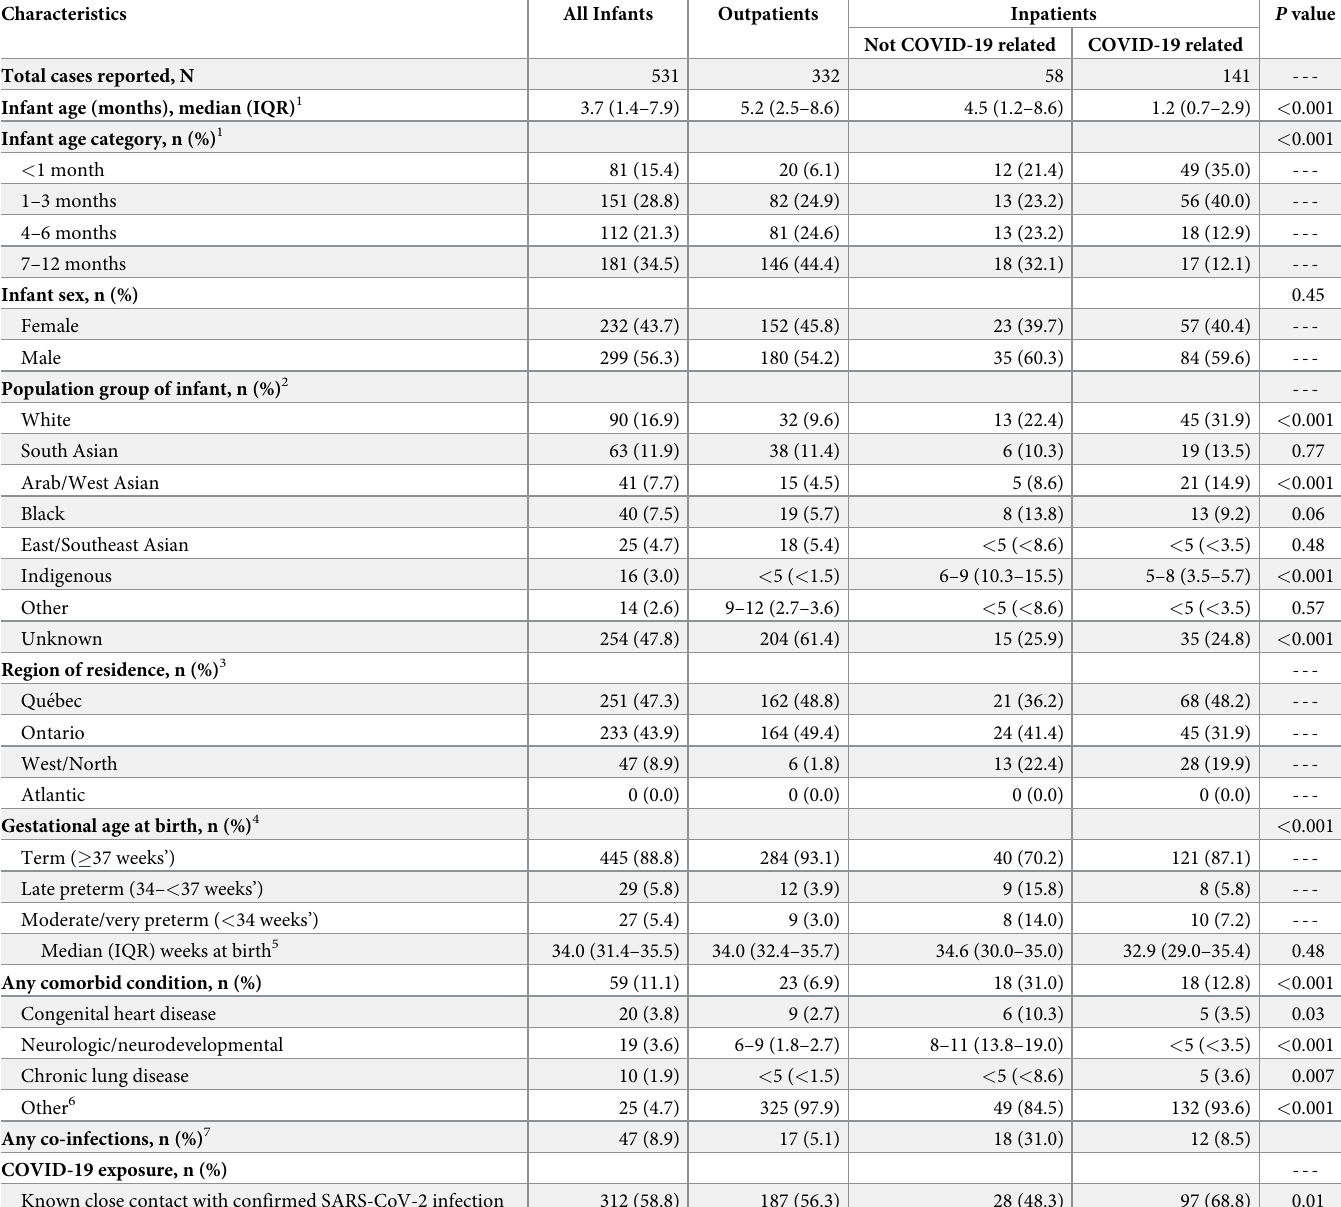
Table 1. Characteristics of infants with SARS-CoV-2 infection in Canada.